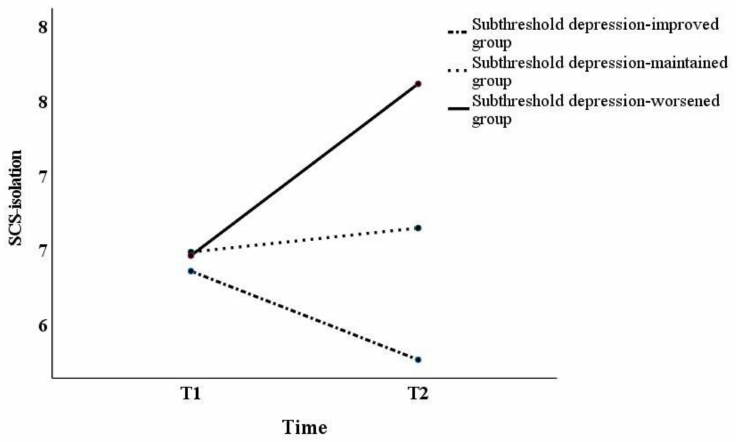
Figure 2. Changes in SCS-Isolation score from T1 to T2. SCS-Isolation, brief version of the Self- Compassion Scale—Isolation.